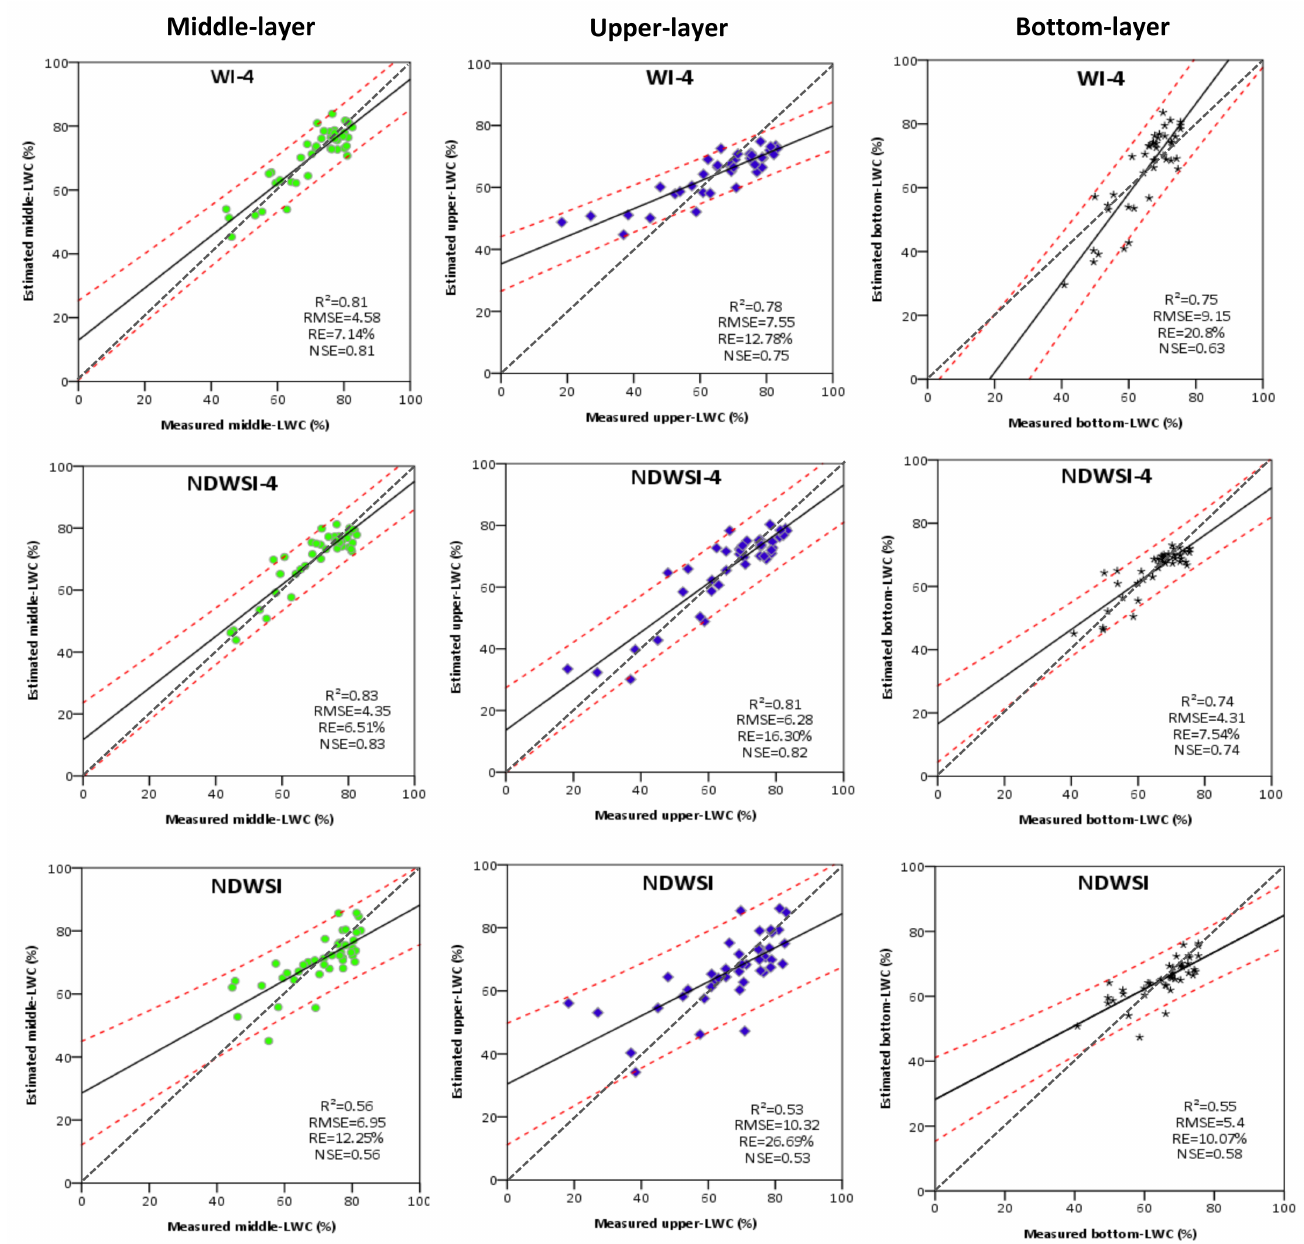
Figure 8. Validation of estimation models derived from the WI-4, NDWSI-4 and NDWSI for the middle-LWC ( green point ), the upper-LWC ( blue diamond ) and the bottom-LWC ( black star ). The black solid lines indicate linear fits, black dash lines indicate 1:1 line, red dash lines indicate the 95% confidence intervals of